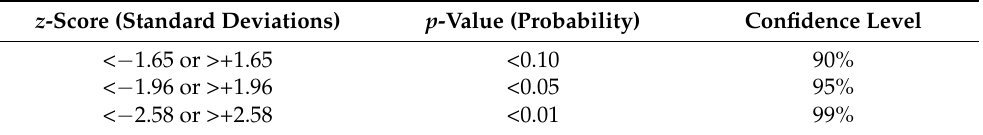
Table 2. The uncorrected critical z -scores and p -values for different confidence levels. z -Score (Standard Deviations) p -Value (Probability) Confidence